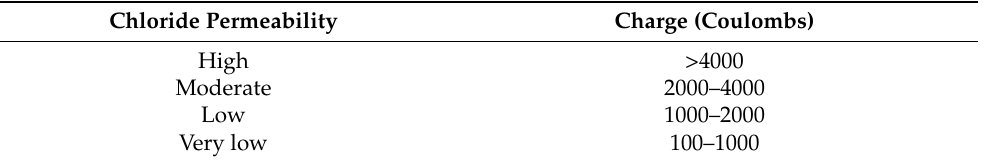
Table 5. Chloride permeability